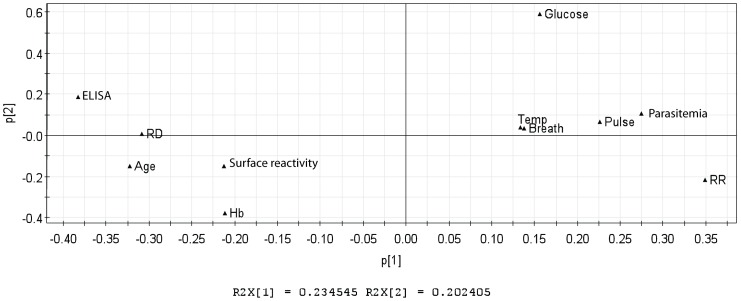
Principal Component Analysis of clinical and immunological data.Data analysis from Cameroonian samples where clinical parameters and immunological data were analyzed using Principal Component Analysis. The principal component analysis generated a model that explains 23% of the data segregation (R2X  = 0.234545). Clinical parameters: temperature (Temp), breath rate (breath), pulse rate (pulse), glucose level (glucose), haemoglobin (Hb), parasitemia, age, rosetting rates (RR, after collection from patients). Immunological parameters: plasma sample recognition of NTS-DBL1α It4var60 domain (ELISA), ability to disrupt FCR3S1.2 rosettes (RD) and ability to recognize FCR3S1.2 iRBC surface by flow cytometry (Surface reactivity).